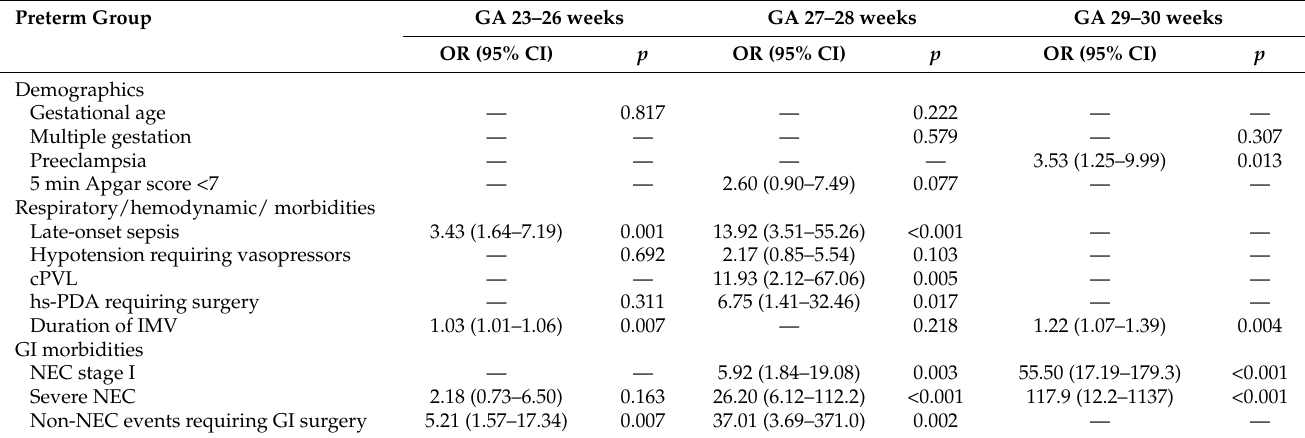
Table 2. Multivariate logistic regression models for the odds ratios of the risks and morbidities related to the adverse feeding trajectory in infants in each gestational age preterm